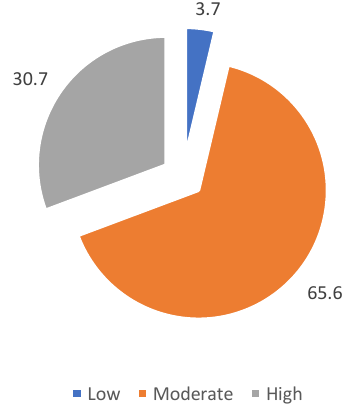
Figure 2. Level of farmers’ beliefs about climate change.